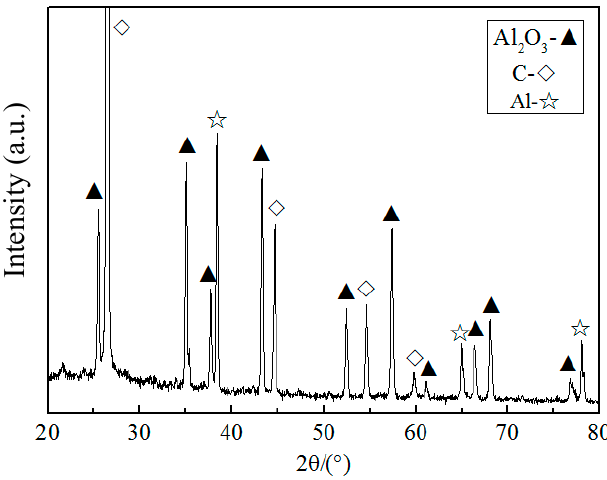
Figure 4. XRD pattern of the as-synthesized sample.